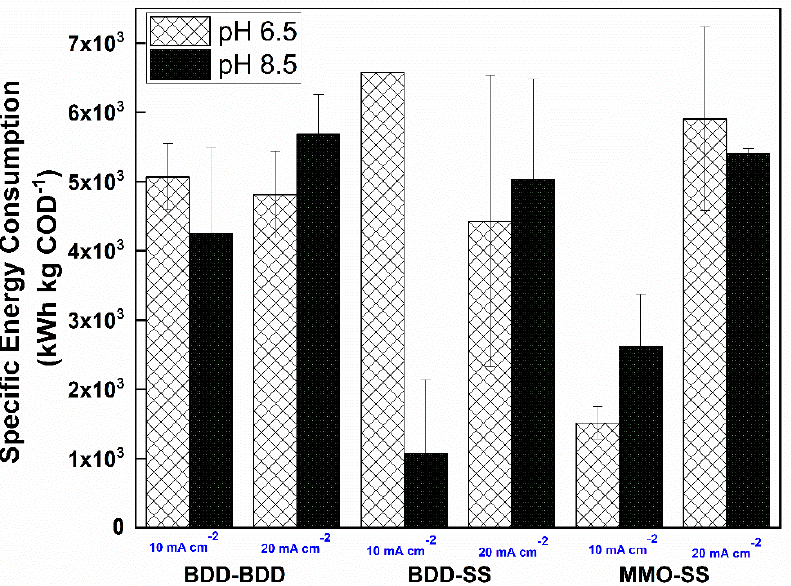
Figure 5. Specific energy consumption of BDD and MMO electrodes at pH 6.5 and 8.5, and current densities of 10 and 20 mA cm − 2 . Error bars showcase the standard deviation.